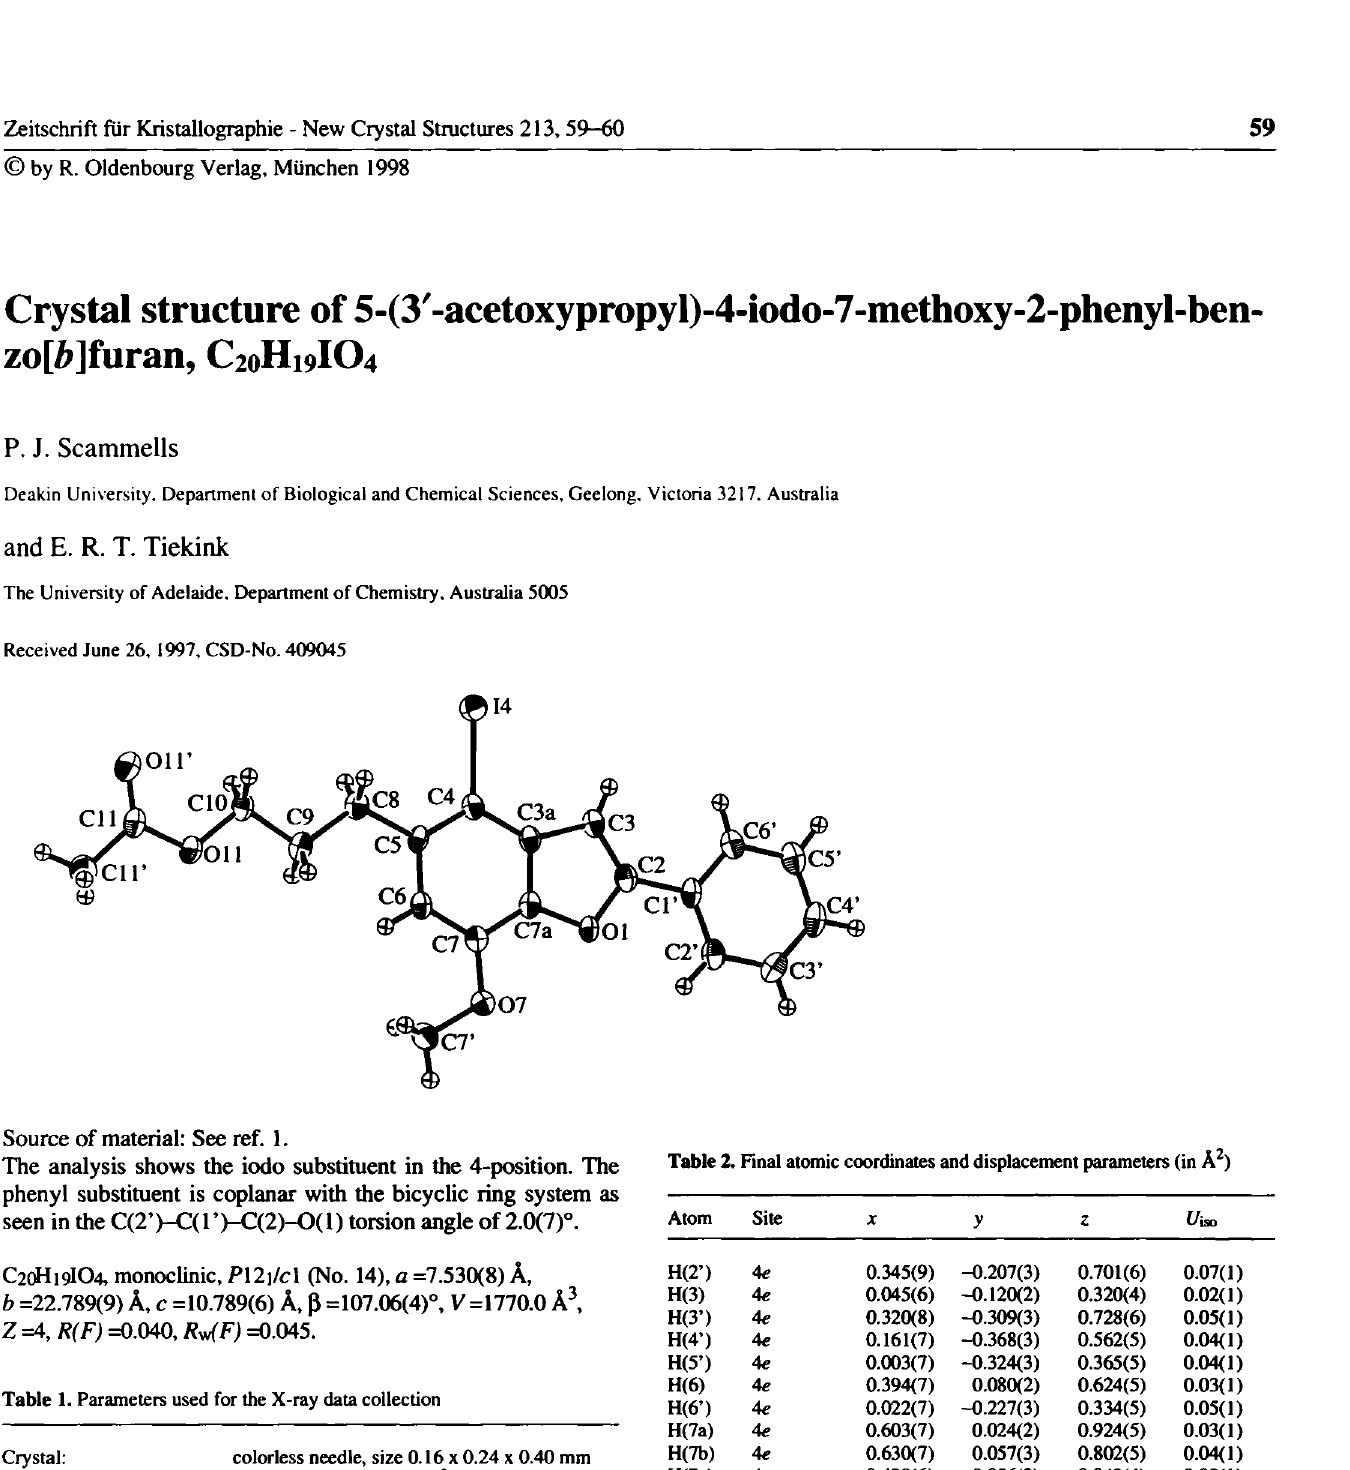
Table 1. Parameters used for the X-ray data collection Crystal: